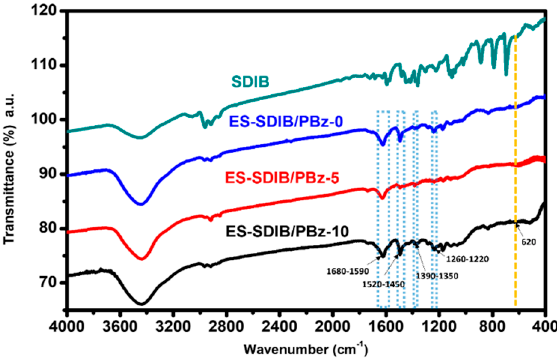
Figure 9. Fourier transform infrared (FTIR) spectra of pure SDIB and ES-SDIB / PBz (0, 5 and 10) nanofibers.